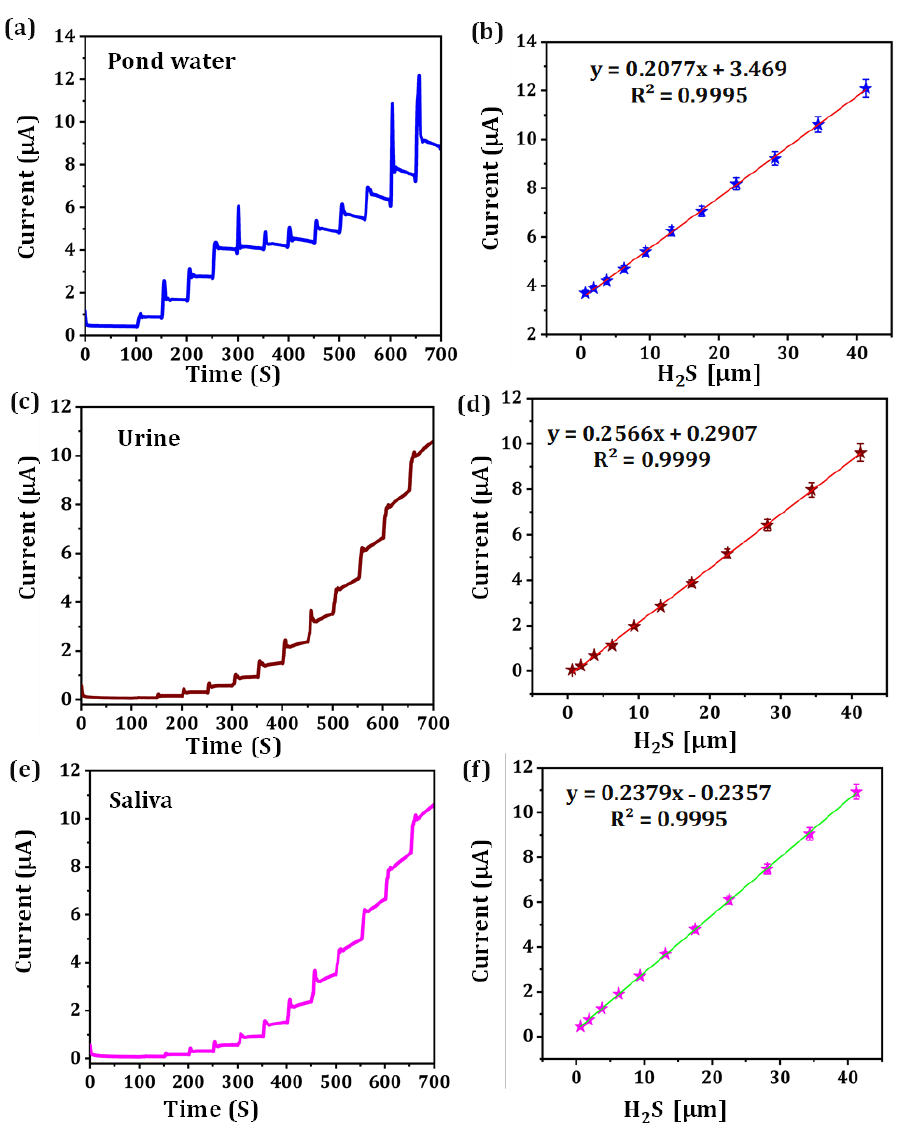
Figure 8. Detection of H 2 S at PtNi-modified electrode in ( a ) pond water, ( c ) urine, and ( e ) saliva samples containing 0.05 M PB (pH 7.0), with corresponding plots of I pa vs. [H 2 S] for ( b ) pond water, ( d ) urine, and ( f ) saliva samples. Table 2. Detection of H 2 S in pond water, urine, and saliva samples with the PtNi-modified electrode. Samples Added ( µ M) Found ( µ